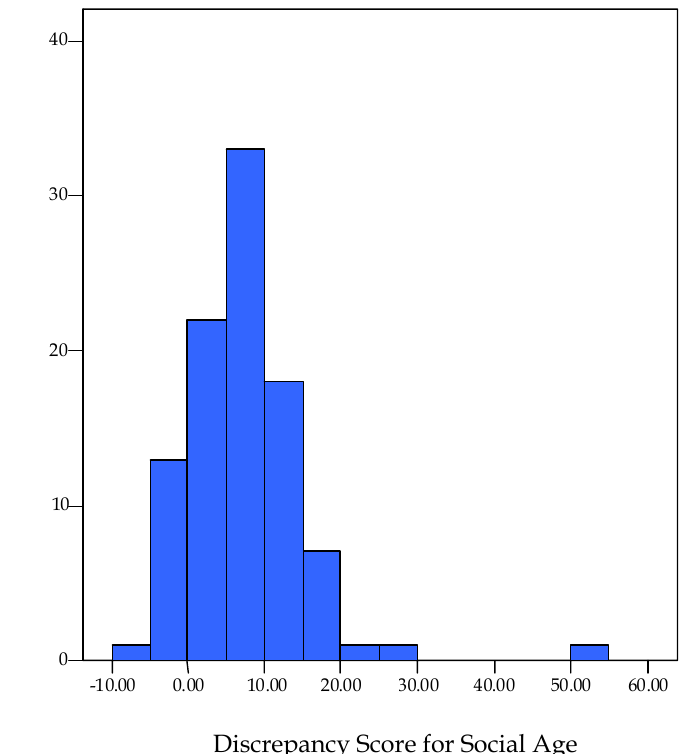
Figure 2 . Age Discrepancy Scores for Social Age: Actual Age minus ‘How others see